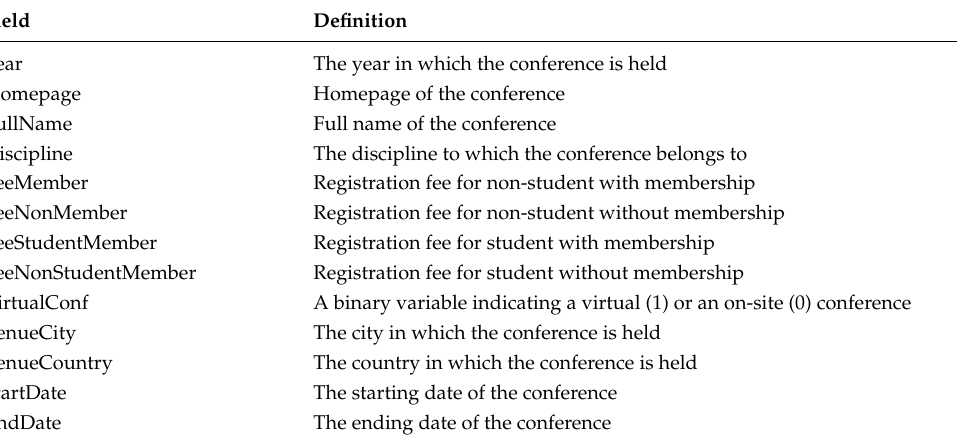
Table A2. Data entries used to collect the conference